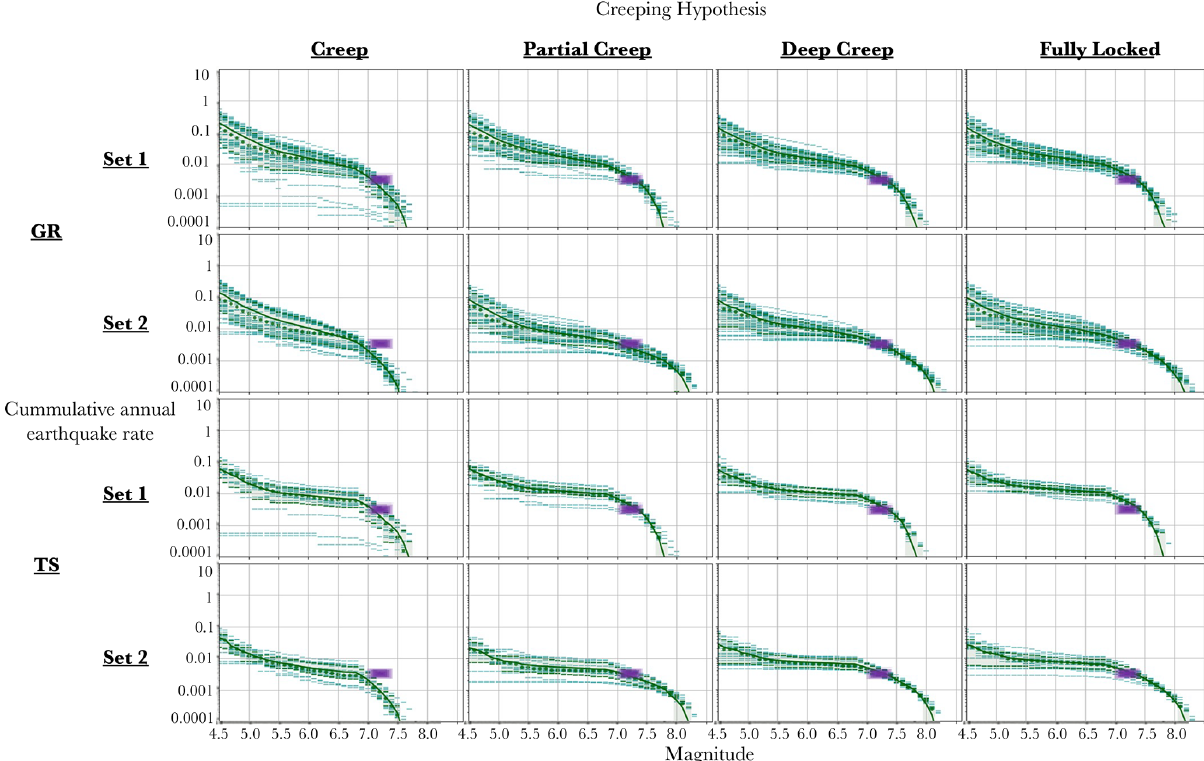
Figure 9. Comparison of the modelled rupture rates with the rates calculated from the palaeo-earthquake record at the Ganos 1 site (Fig. 2) for different branches of the logic tree. The green curves are the modelled rate of ruptures rupturing the Ganos segment. The dashed lines are each individual model of the logic tree. The dotted lines are the 16th and 84th percentiles of the distribution, and the continuous line is the mean value of the distribution. Palaeo-earthquake rates are in purple (Table